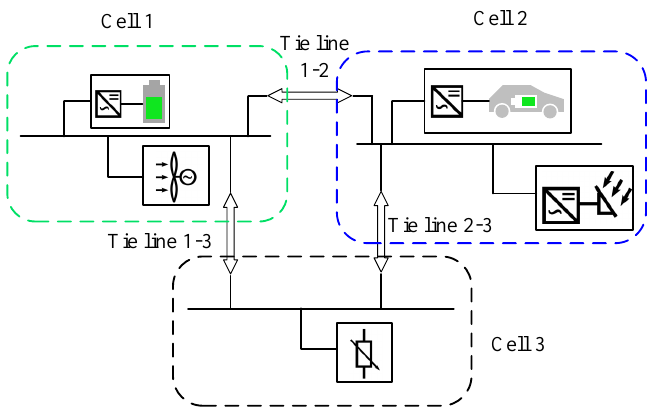
Figure 6. Three-cell based system. Table 1. Comparison of cost index regarding different time intervals.